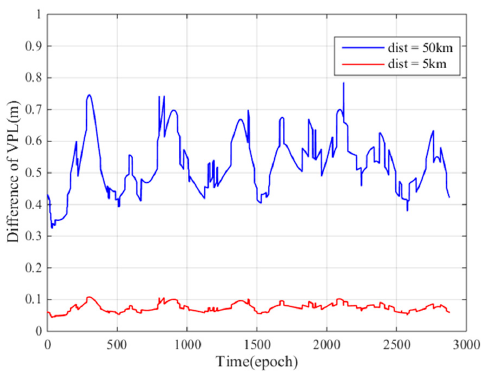
Figure 14. VPL differences when the distances between GBAS are 50 km and 5 km.